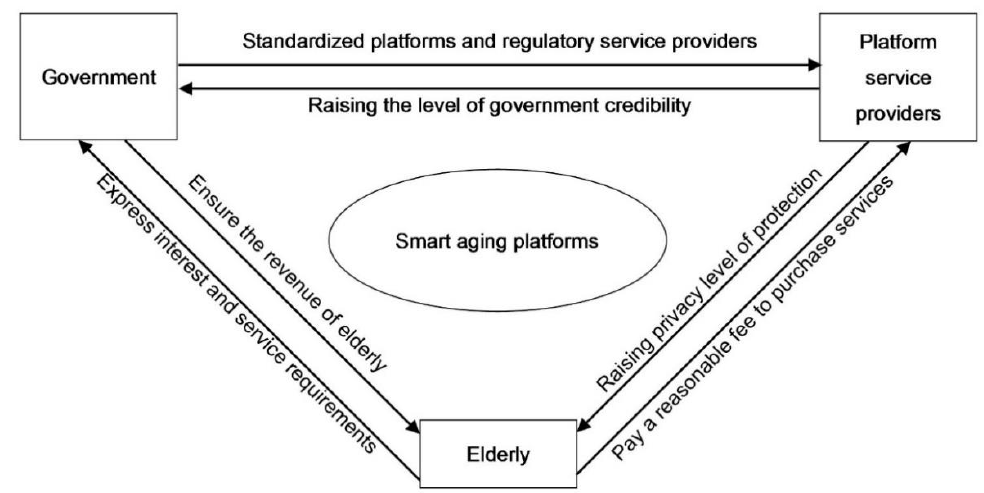
Figure 1. Subject relationship.